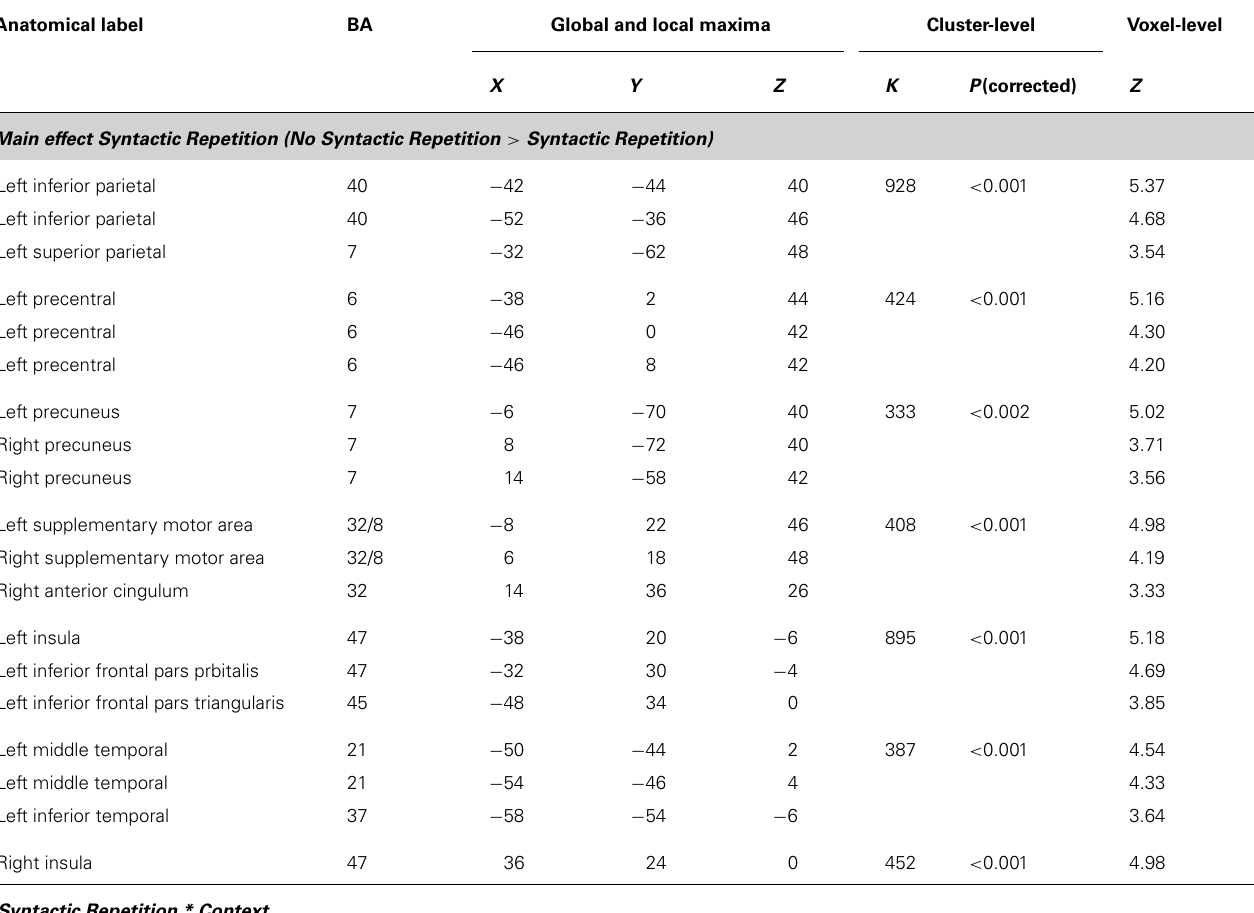
BA Global and local